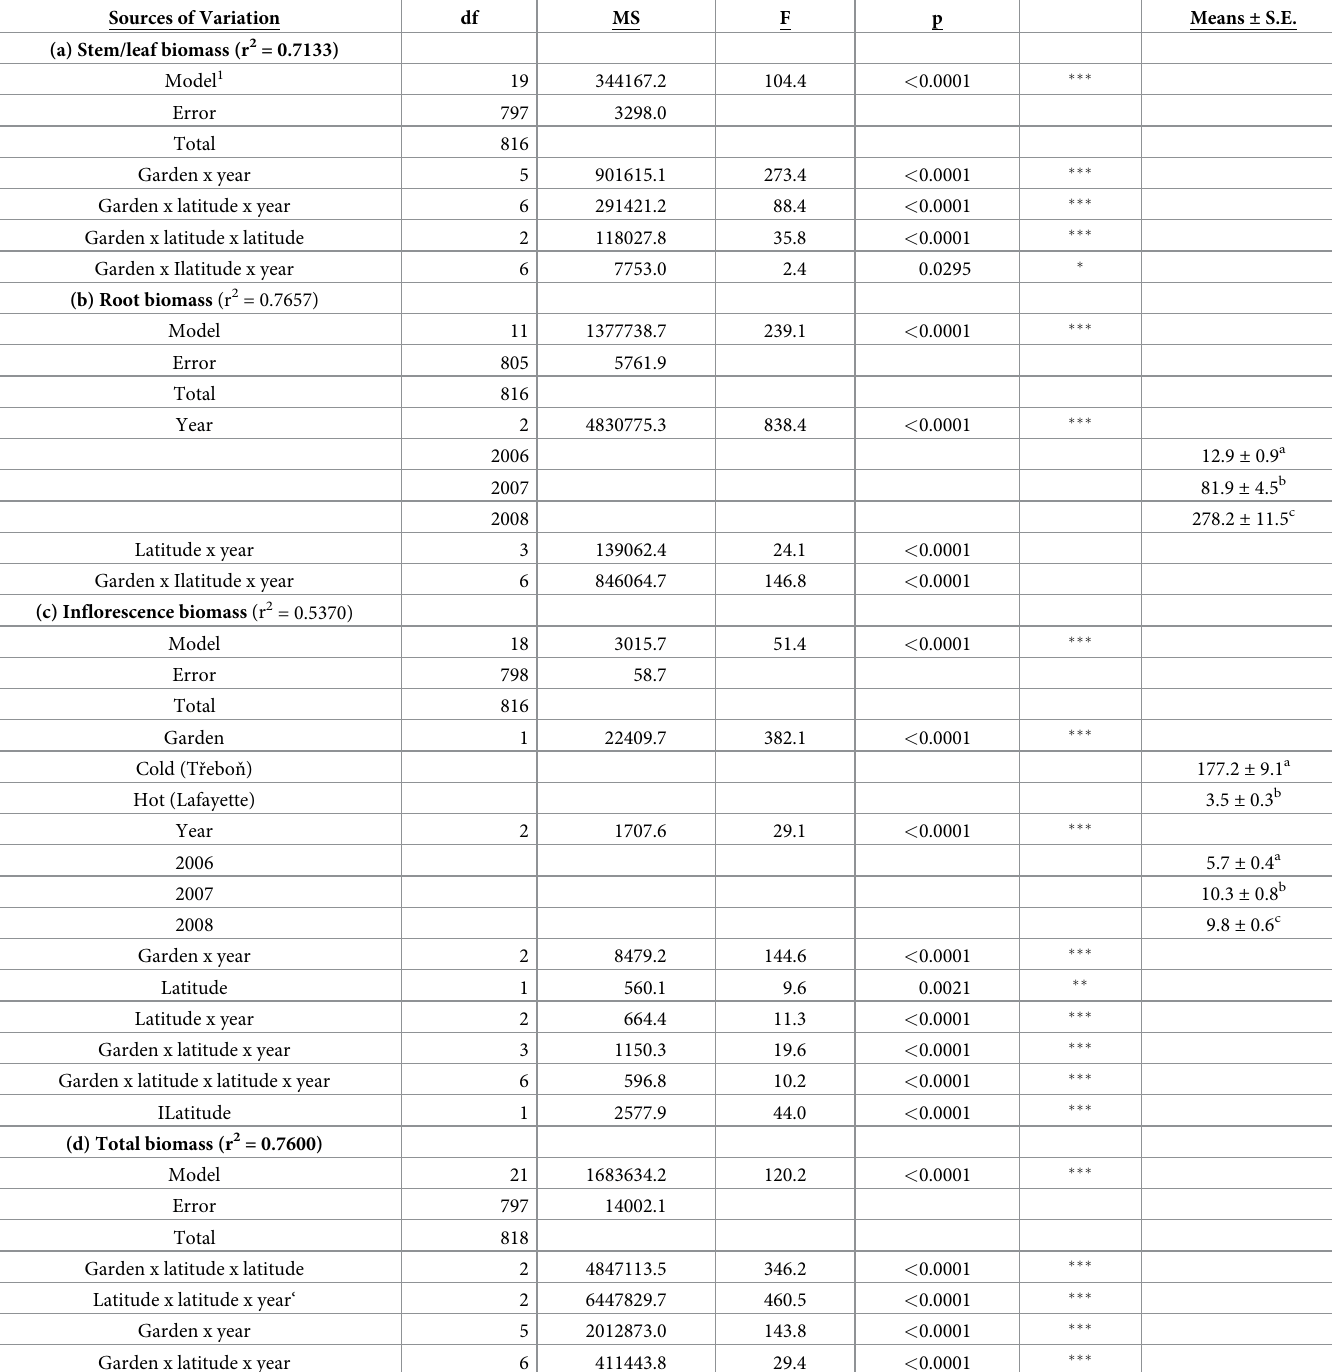
Table 2. ANOVA table of the effects of sources of variation on tissue biomass (g) of Lythrum salicaria including total (a), above-ground (b), below-ground (c) and inflorescence (d). Sources of Variation df MS F p Means ±